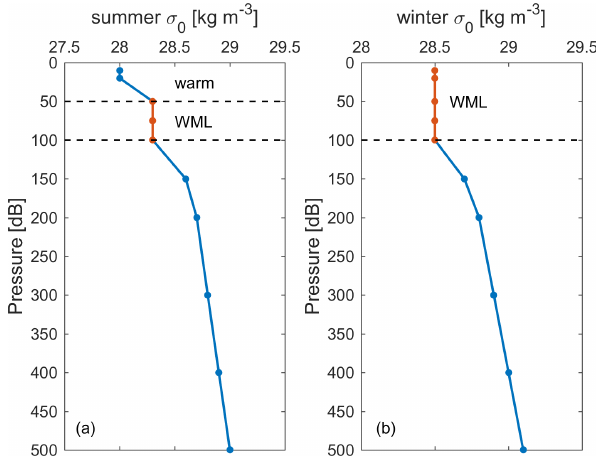
Figure 7. Example of the winter mixed layer (WML) depth (marked as red) determined in (a) summer and (b) winter in potential den- sity ( σ 0 ) profiles specifically for historical surface saturation calcu-